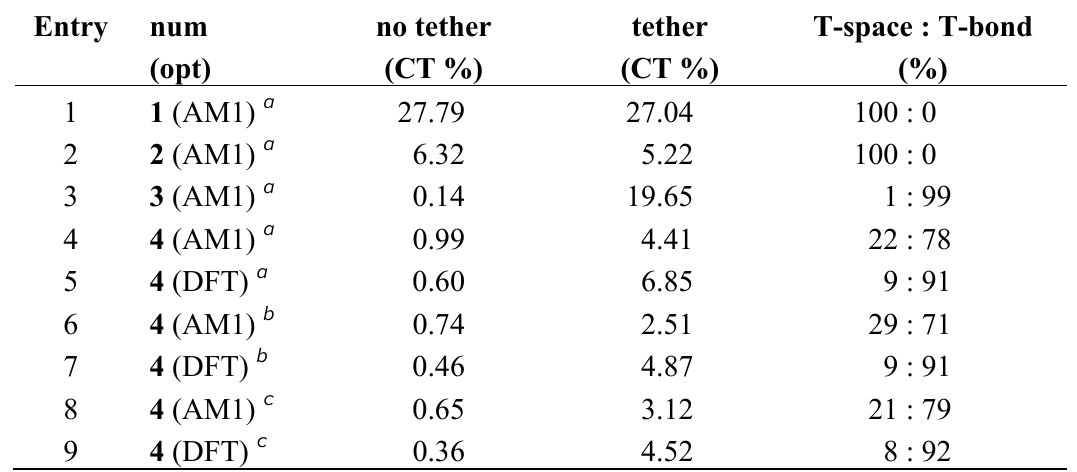
Table 3. The relative contributions of CT-exciton to the lowest excited state of cyclophandiene 1-4 [47]. Reproduced with permission from American Chemical